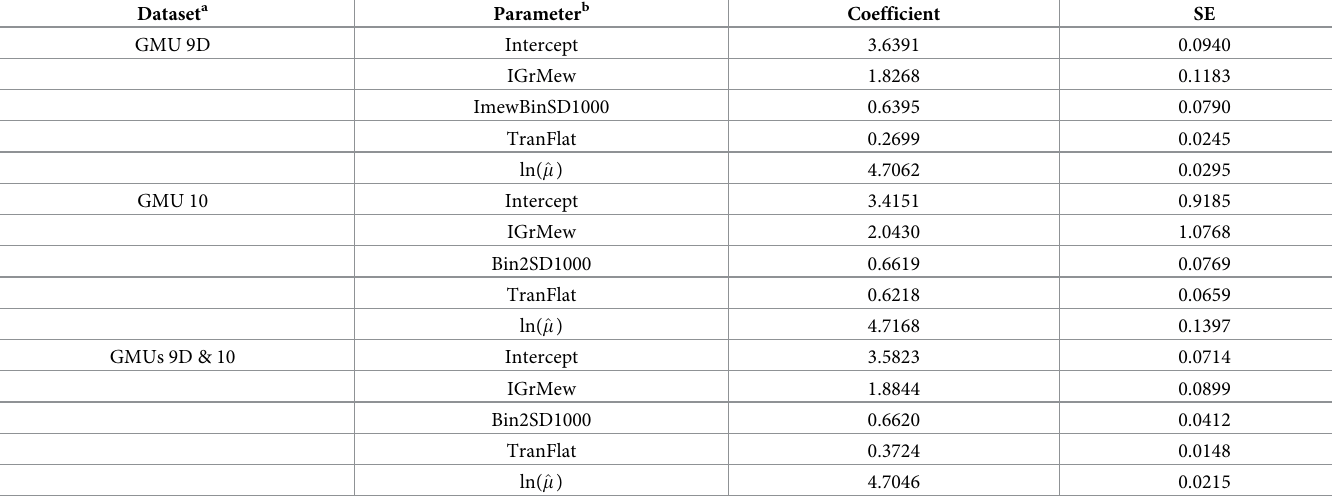
Table 2. Coefficients and standard errors of the best fitting multiple covariate distance sampling (MCDS) models of bear detections in GMU 9D, GMU 10, and GMU 9D and 10 combined southern Alaska Peninsula,